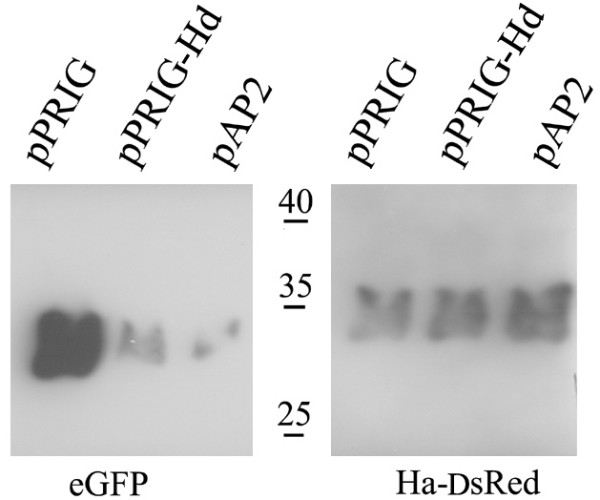
Comparison of the pPRIG-HA-Red (pPRIG), pPRIG-Hd-HA-Red (pPRIG-Hd) and pAP2-HA-Red (pAP2) GFP and RFP protein expression by Western blot analysis. Equivalent amounts of cell lysates containing the eGFP and HA-DsRed expressed from the indicated vectors were loaded in duplicate, ran on SDS-PAGE, and analyzed with an anti GFP serum (left panel) and an anti-HA serum (right panel).